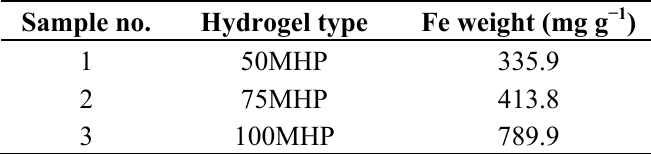
Table 2. Type of hydrogel and total mass of iron oxide per gram of dried magnetic